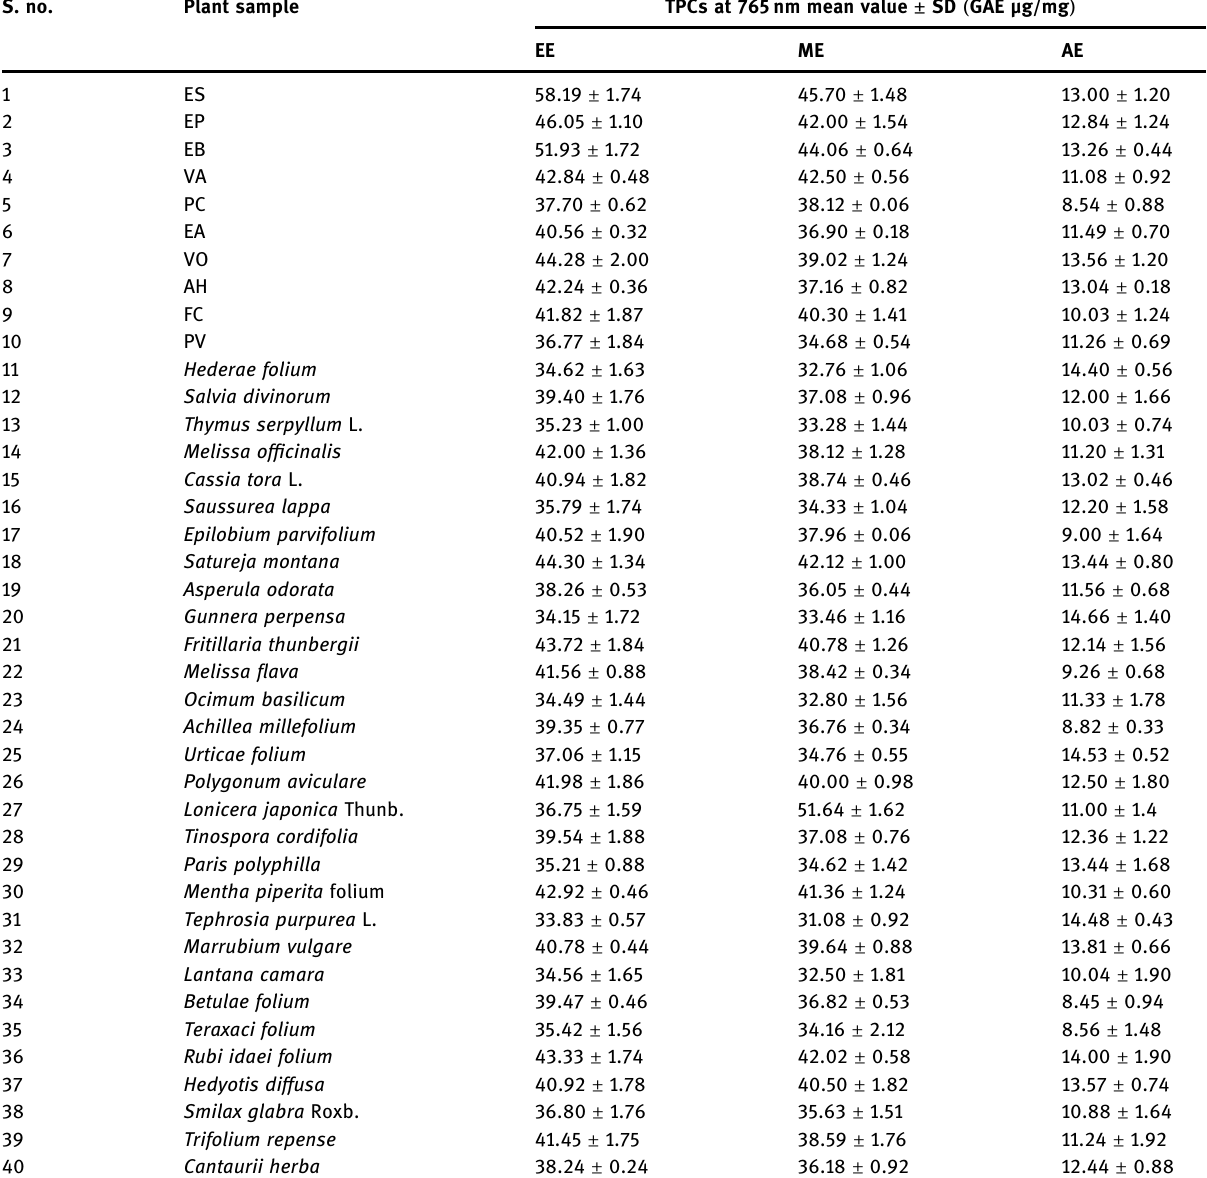
Table 2: TPCs found in various medicinal plants at 765 nm S. no. Plant